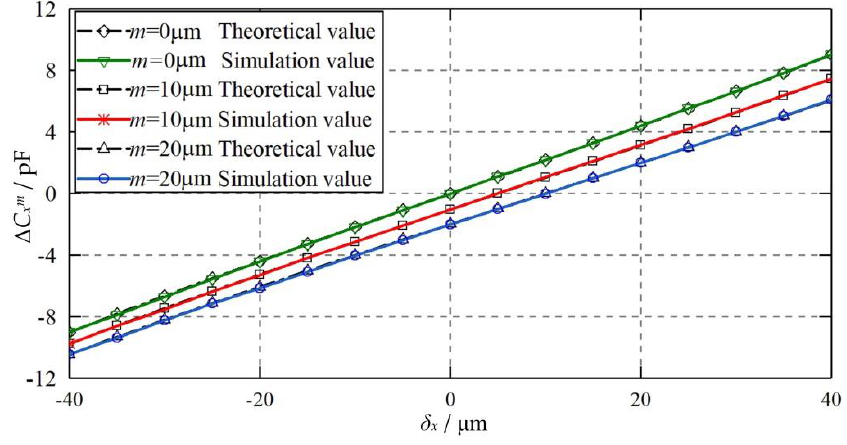
Figure 13. Dependence of the differential capacitance Δ C xm on the eccentric displacement of the ball when the plate is axial offset.